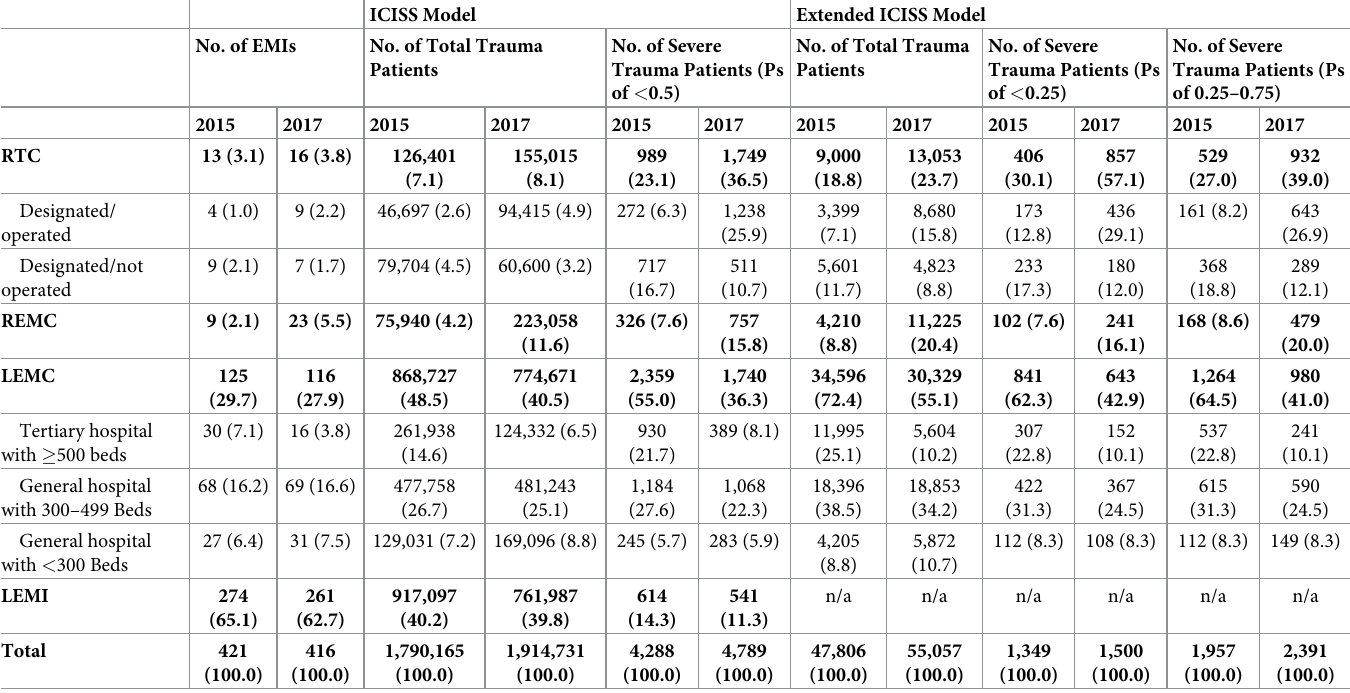
Table 2. Comparison of the number of trauma patients according to the type of emergency medical institution � . ICISS